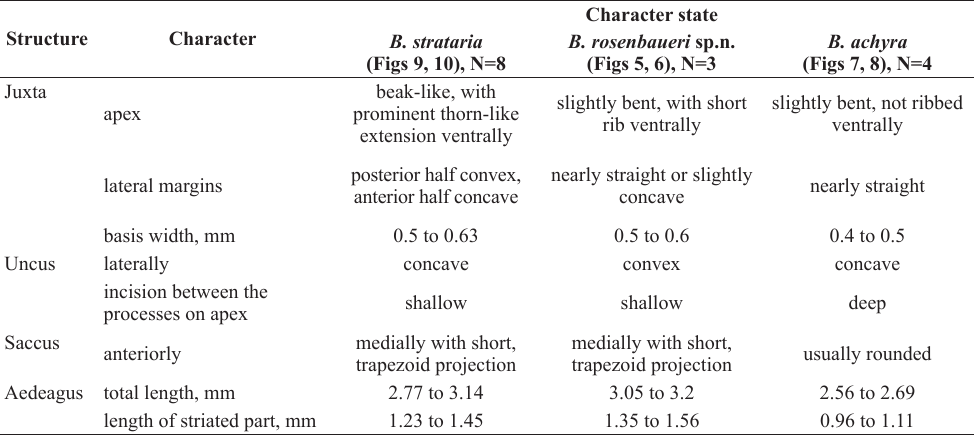
Table 1. Differential characters in the male genitalia of B. strataria , B. rosenbaueri sp. n. and B. achyra .